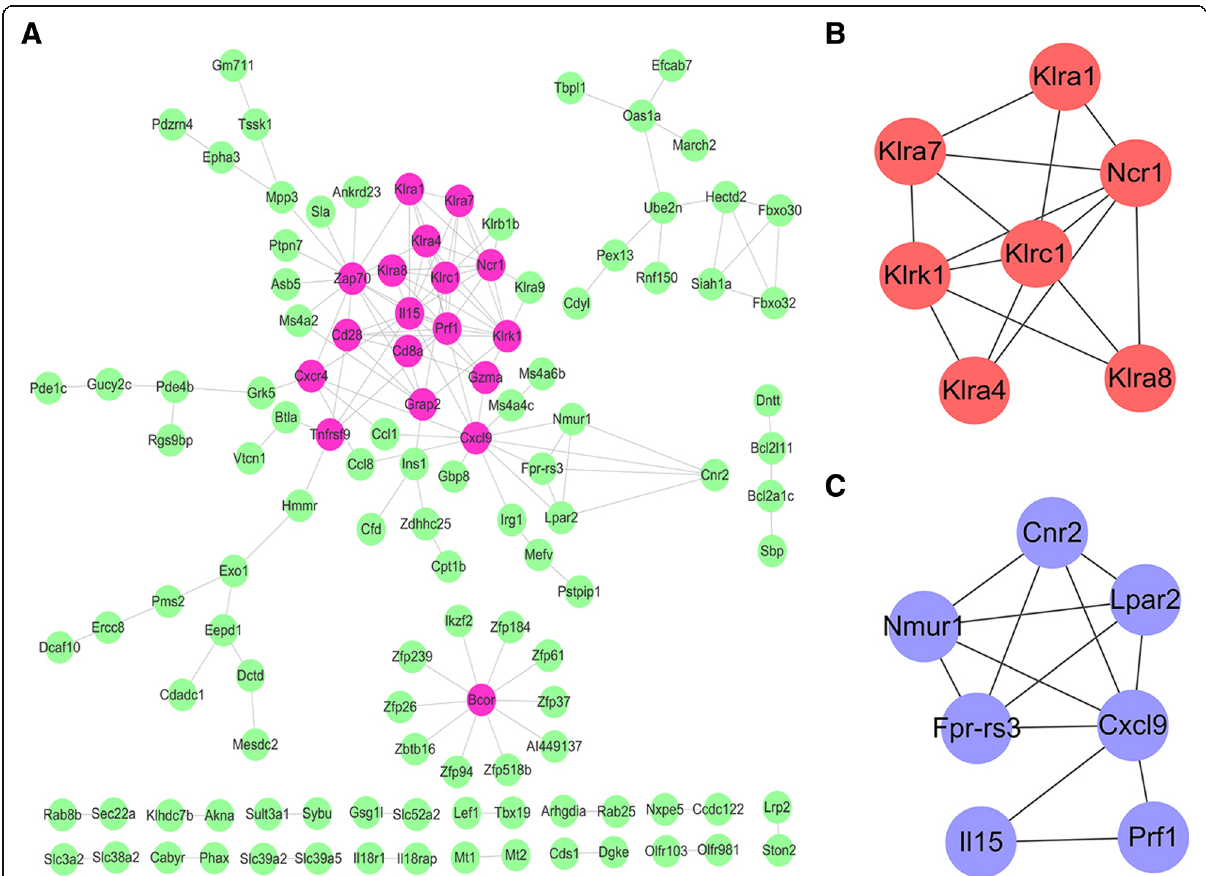
Fig. 4 PPI networks. a PPI network with 118 nodes. Pink nodes represent the hub nodes with more neighbors ( ≥ 5). b A significant module with 7 nodes are identified by MCODE (score = 5). c A significant module with 7 nodes are identified by MCODE (score =